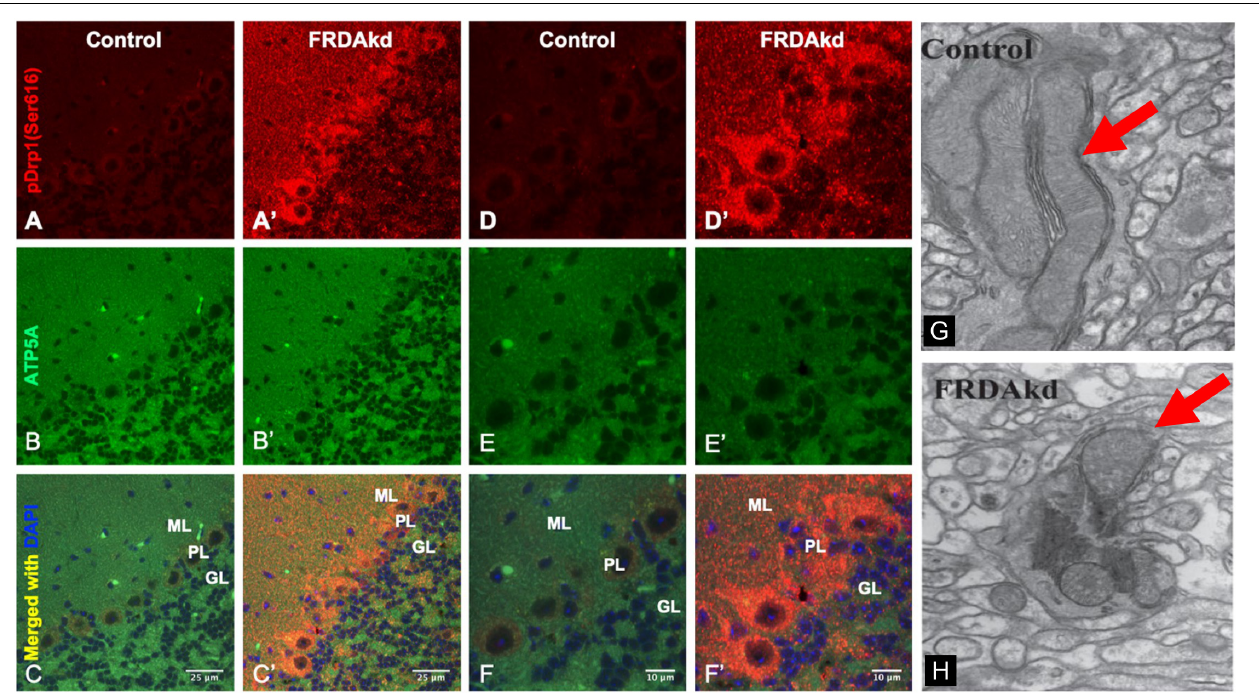
FIGURE 4 | The cerebellum of FRDAkd mice display fragmented mitochondria and phospho-Drp1 (S616) increase localized to the cerebellar cortex and Purkinje neurons. Confocal images of phospho-Drp1 (S616) (red) and mitochondrial marker ATP5A (green) immunofluorescence and merged images with DAPI-stained nuclei (blue) in the cerebellar cortex and Purkinje neurons of FRDAkd (A (cid:48) –F (cid:48) ) and age-matched control mice (A–F) at 8–12 weeks of dox treatment. Scale bars as indicated. Molecular layer (ML), Purkinje layer (PL), and granular layer (GL) are labeled. Electron microscopy images show fragmented mitochondria in FRDAkd mouse (H) cerebellar Purkinje neurons compared with age-matched control mice (G) at 18-weeks of dox treatment. Red arrows indicate